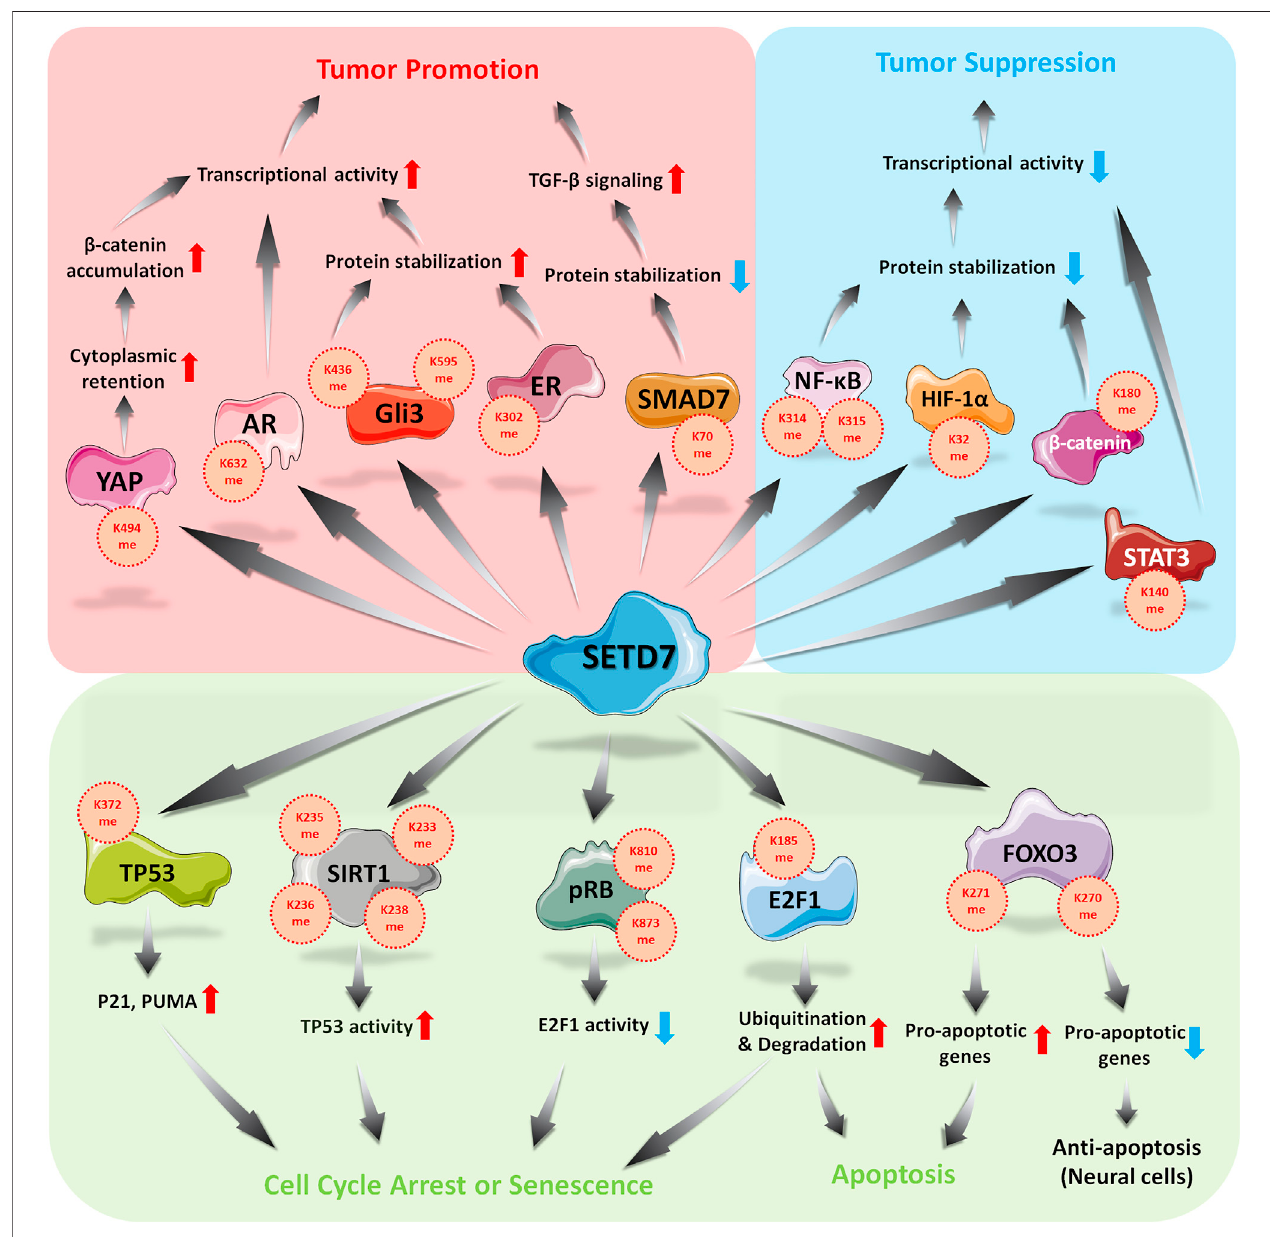
FIGURE 1 | Roles of SETD7 in regulation of cell cycle, apoptosis and external